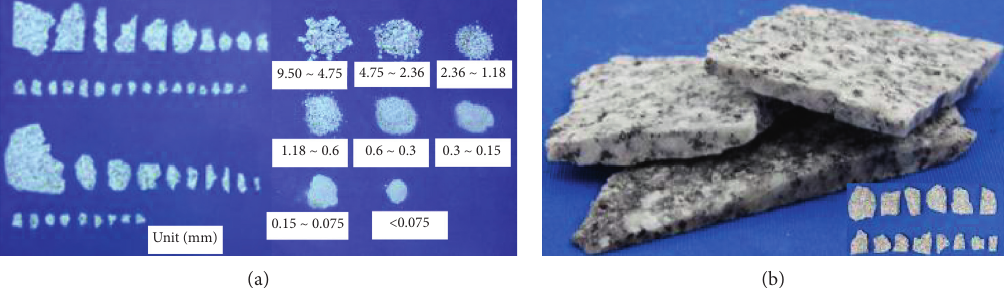
Figure 3: Characteristics of fragments generated from a seismically induced rockburst (sample CD-Z-3): (a) fragments distribution and (b) slab and slice shaped